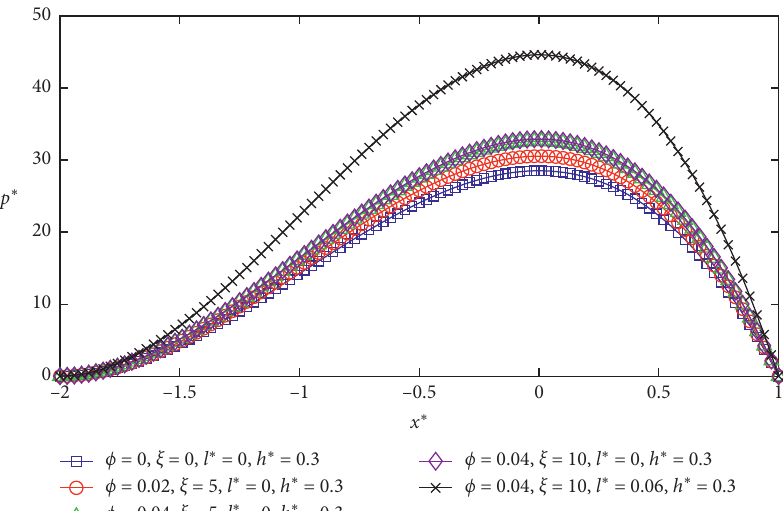
Figure 3: Pressure distribution for different values of Φ , ξ , and l ∗ at h ∗ � 0.3.